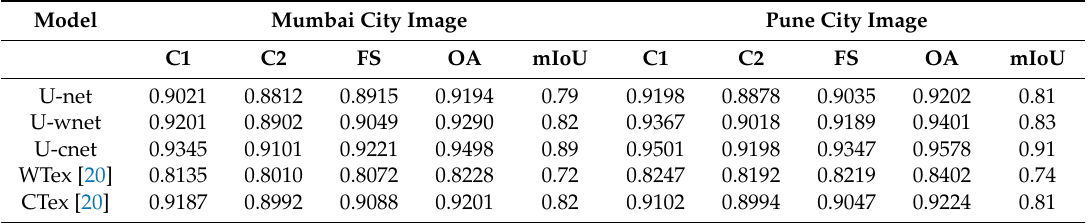
Table 1. Performance